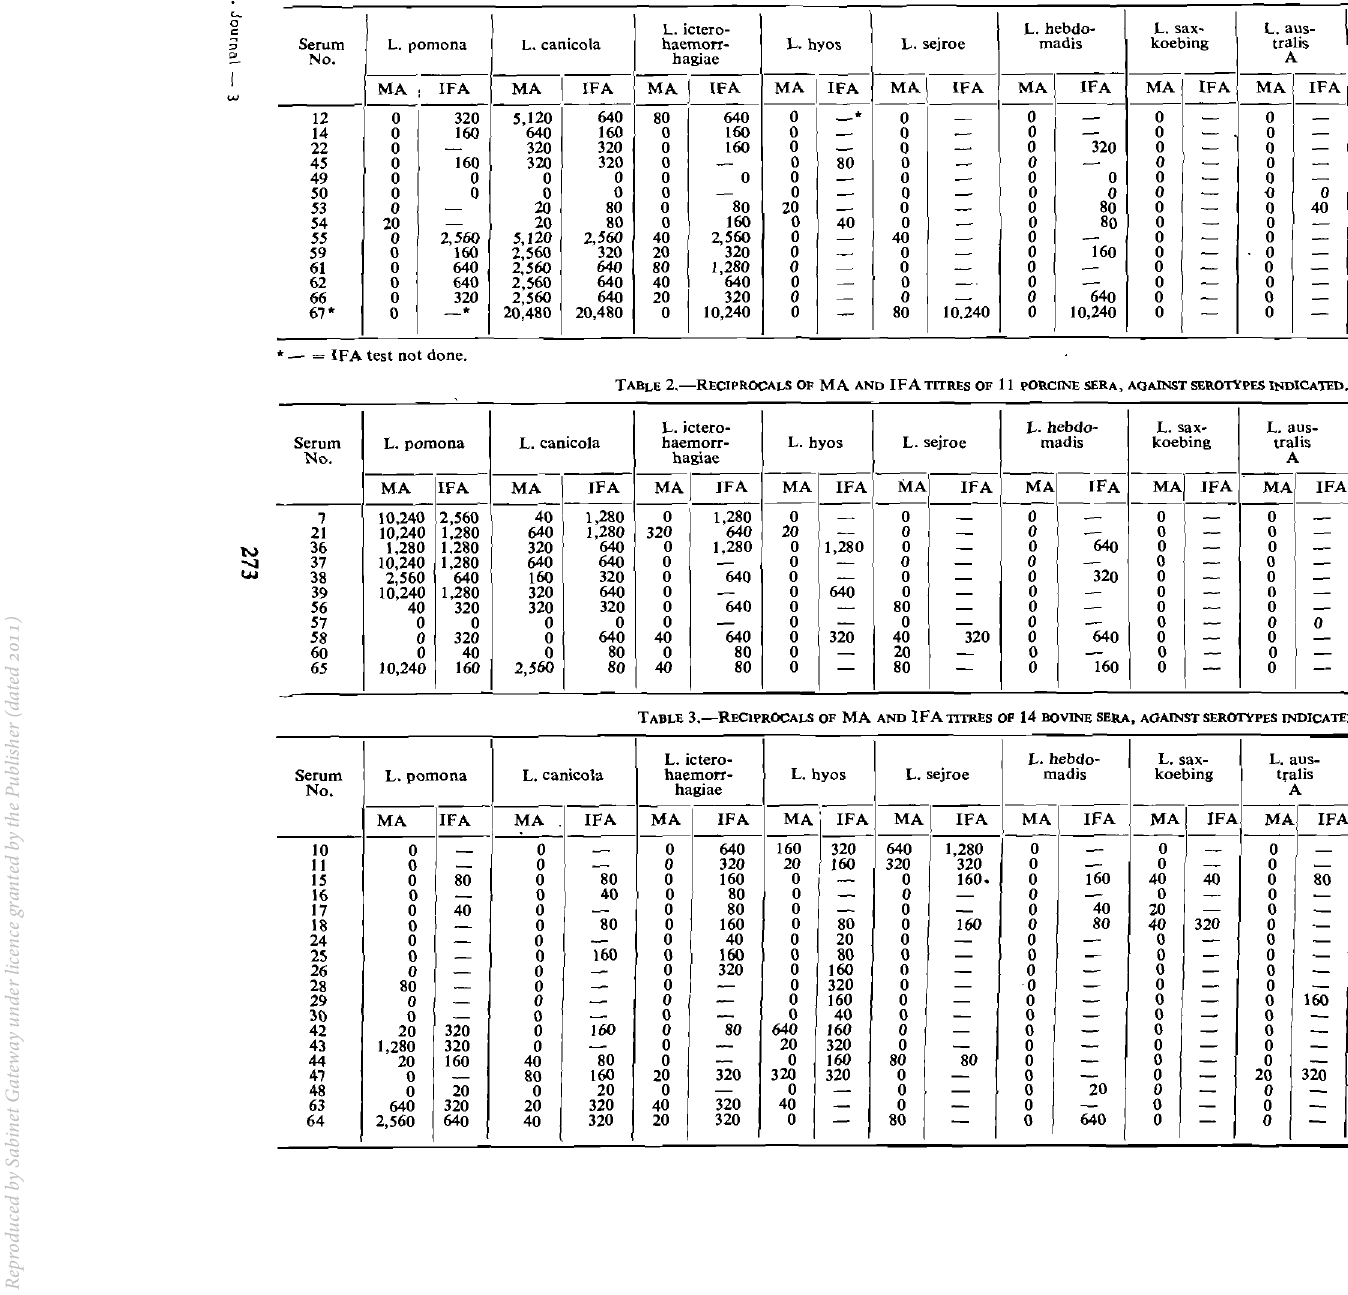
TABLE I.-RECIPROCALS OF MA ANn IFA TIT RES 01' 14 CANINE SERA AGAlNST SIoROTYPES )ND)CATIoP.